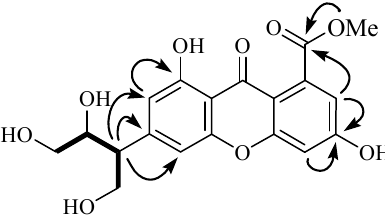
Figure 2. The key HMBC and COSY correlations of compound 1